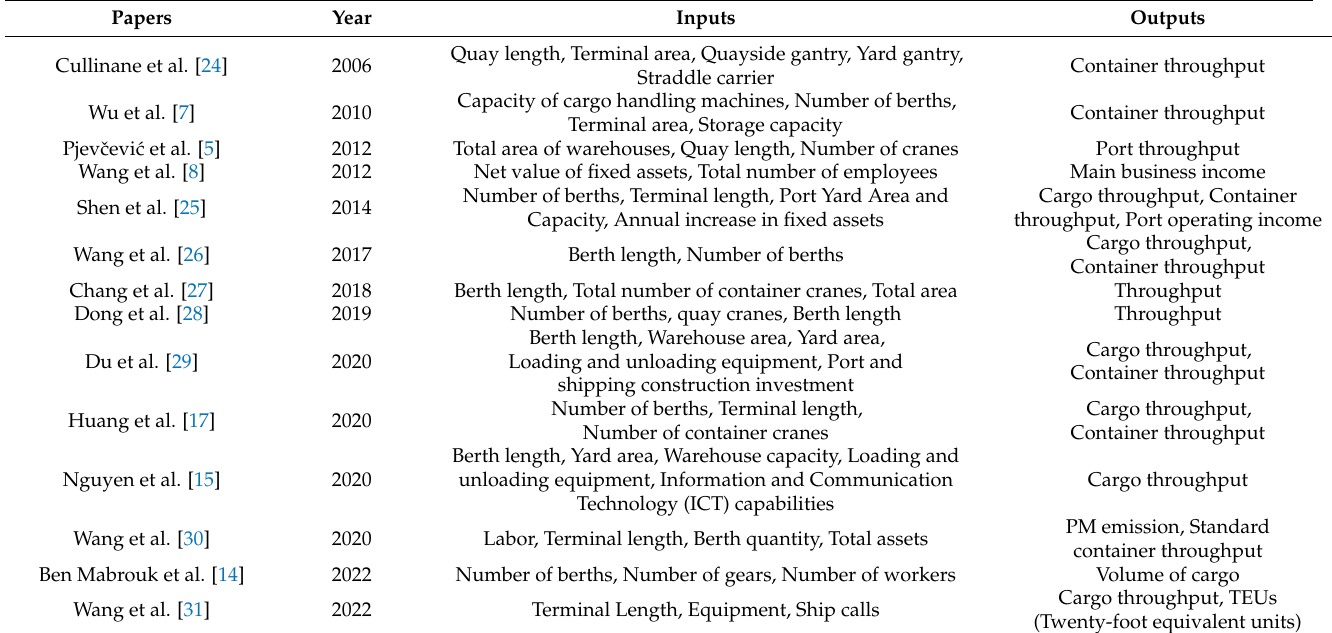
Table 1. The input and output variables in the previous